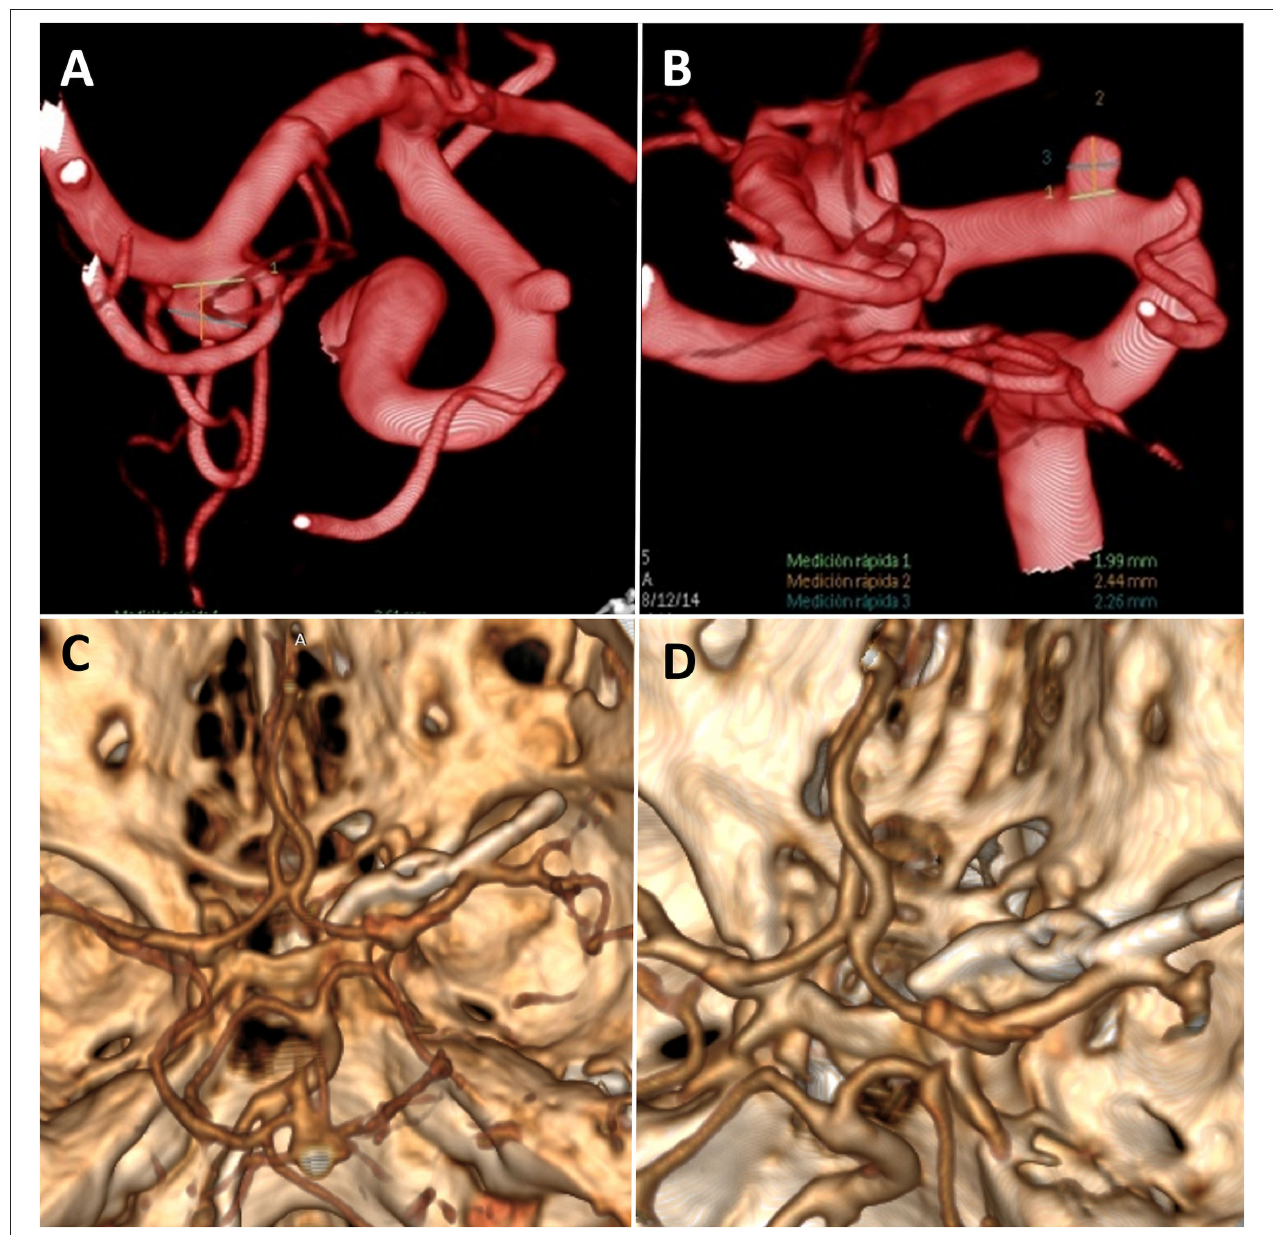
FIGURE 3 | (A,B) Preoperative digital 3D angiographic reconstruction of case 2 where we can observe two right cerebral aneurysms; a medial cerebral artery and a superior carotid-ophthalmic aneurysm. (C,D) Postoperative CT angiography showing the foraminotomy and aneurysms clipped.